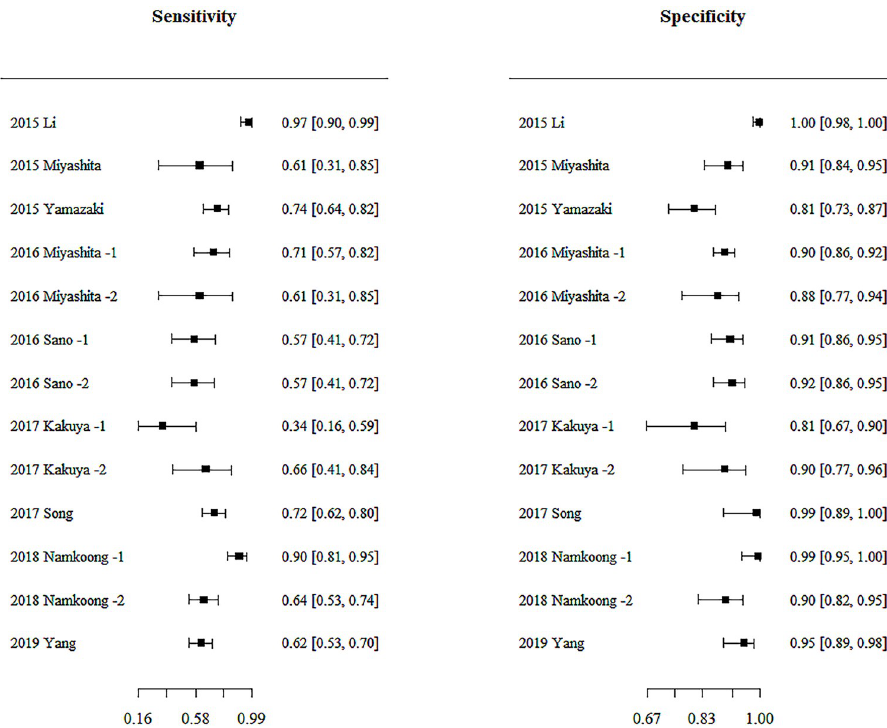
Fig 3. Coupled forest plots of the sensitivity and specificity of immunochromatographic tests for diagnosing Mycoplasma pneumoniae infection. The studies are indicated by year and author name. The numbers are pooled estimates with 95% confidence interval (CI) in brackets. Horizontal lines indicate 95% CIs.